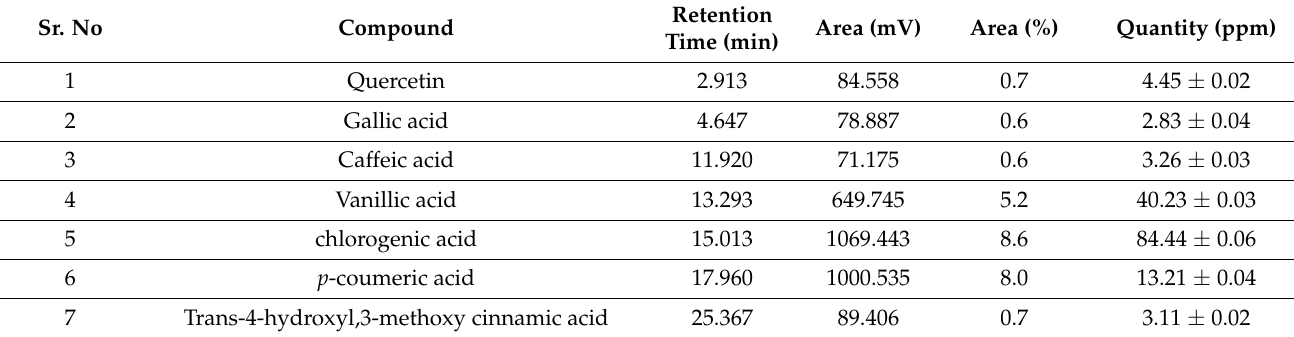
Table 2. HPLC profile of ethyl acetate fraction of B. calliobotrys